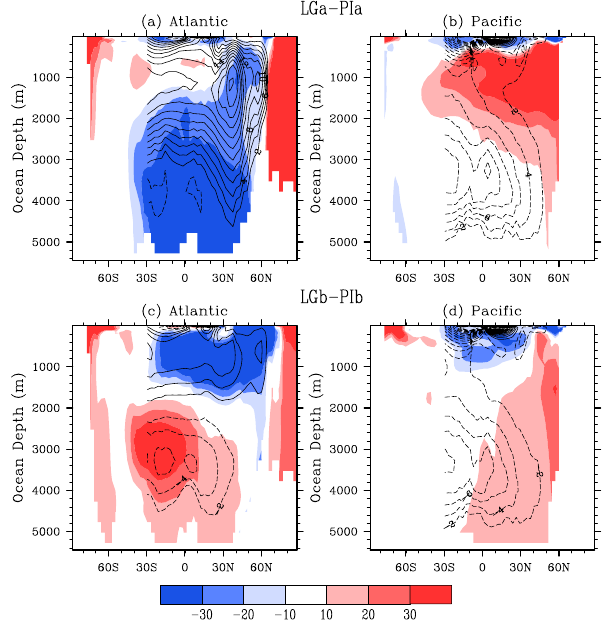
Fig. 7. Atlantic and Pacific DIC anomalies (mmolm − 3 ) (a and b) between LGa and PIa and (c and d) between LGb and PIb. Con- tour lines indicate the overturning stream function of each glacial simulation. Contour intervals are